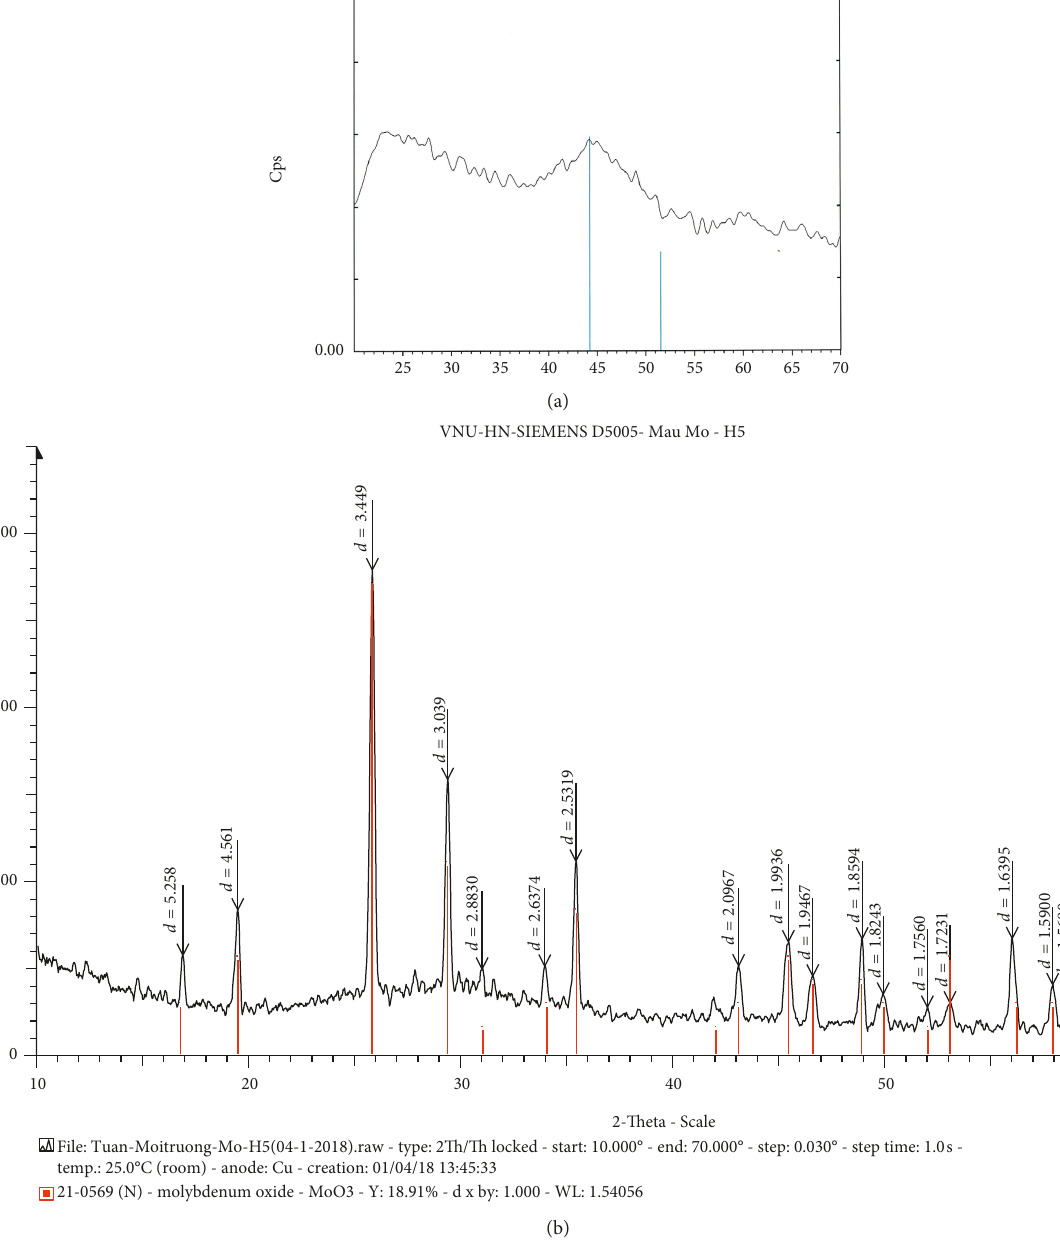
Figure 2: XRD spectra of nano Co (a) and nano MoO